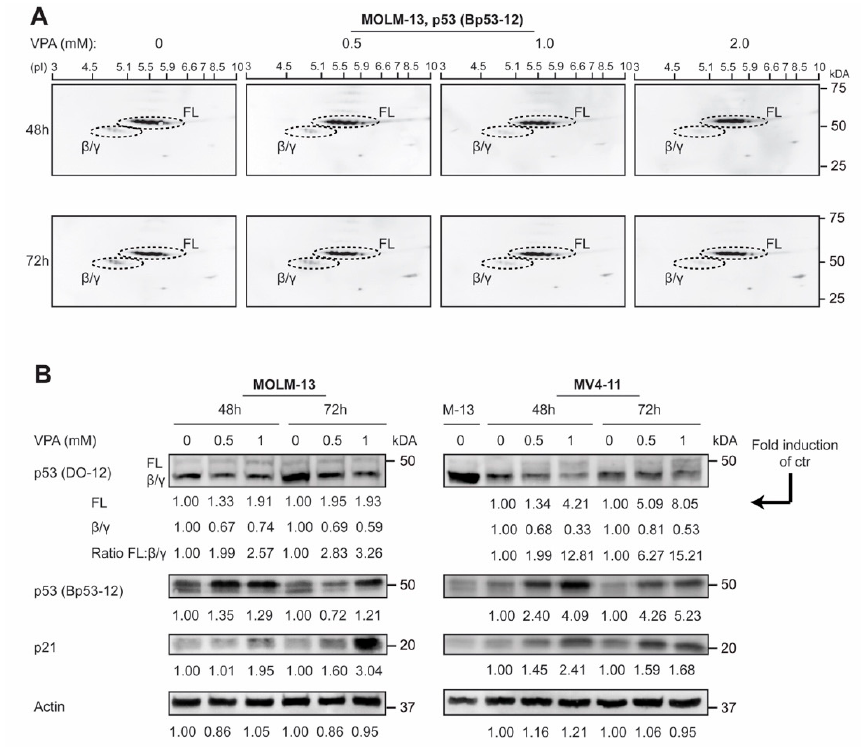
Figure 3. Valproic acid-induced modulation of p53 protein isoforms in AML cell lines. ( A ) The AML cell line MOLM-13 (AML FAB M5a) was treated with VPA (0, 0.5, 1.0 and 2.0 mM) for 48 and 72 h, and analyzed by 2D gel electrophoresis and Western blotting for the detection of p53 full-length (FL), p53 β and p53 γ protein isoforms (Bp53-12). ( B ) AML cell lines MOLM-13 and MV4-11 (AML FAB M5) were treated with VPA (0, 0.5, and 1.0 mM) for 48 and 72 h and analyzed by 1D gel electrophoresis and Western blotting using antibodies against p53 (DO-12), p53 (Bp53-12) and p21. Actin was used as a loading control. Regions in Western blots (p53 DO-12) were quantified, and ratios of p53 FL: p53 β / γ were calculated and given as fold induction of